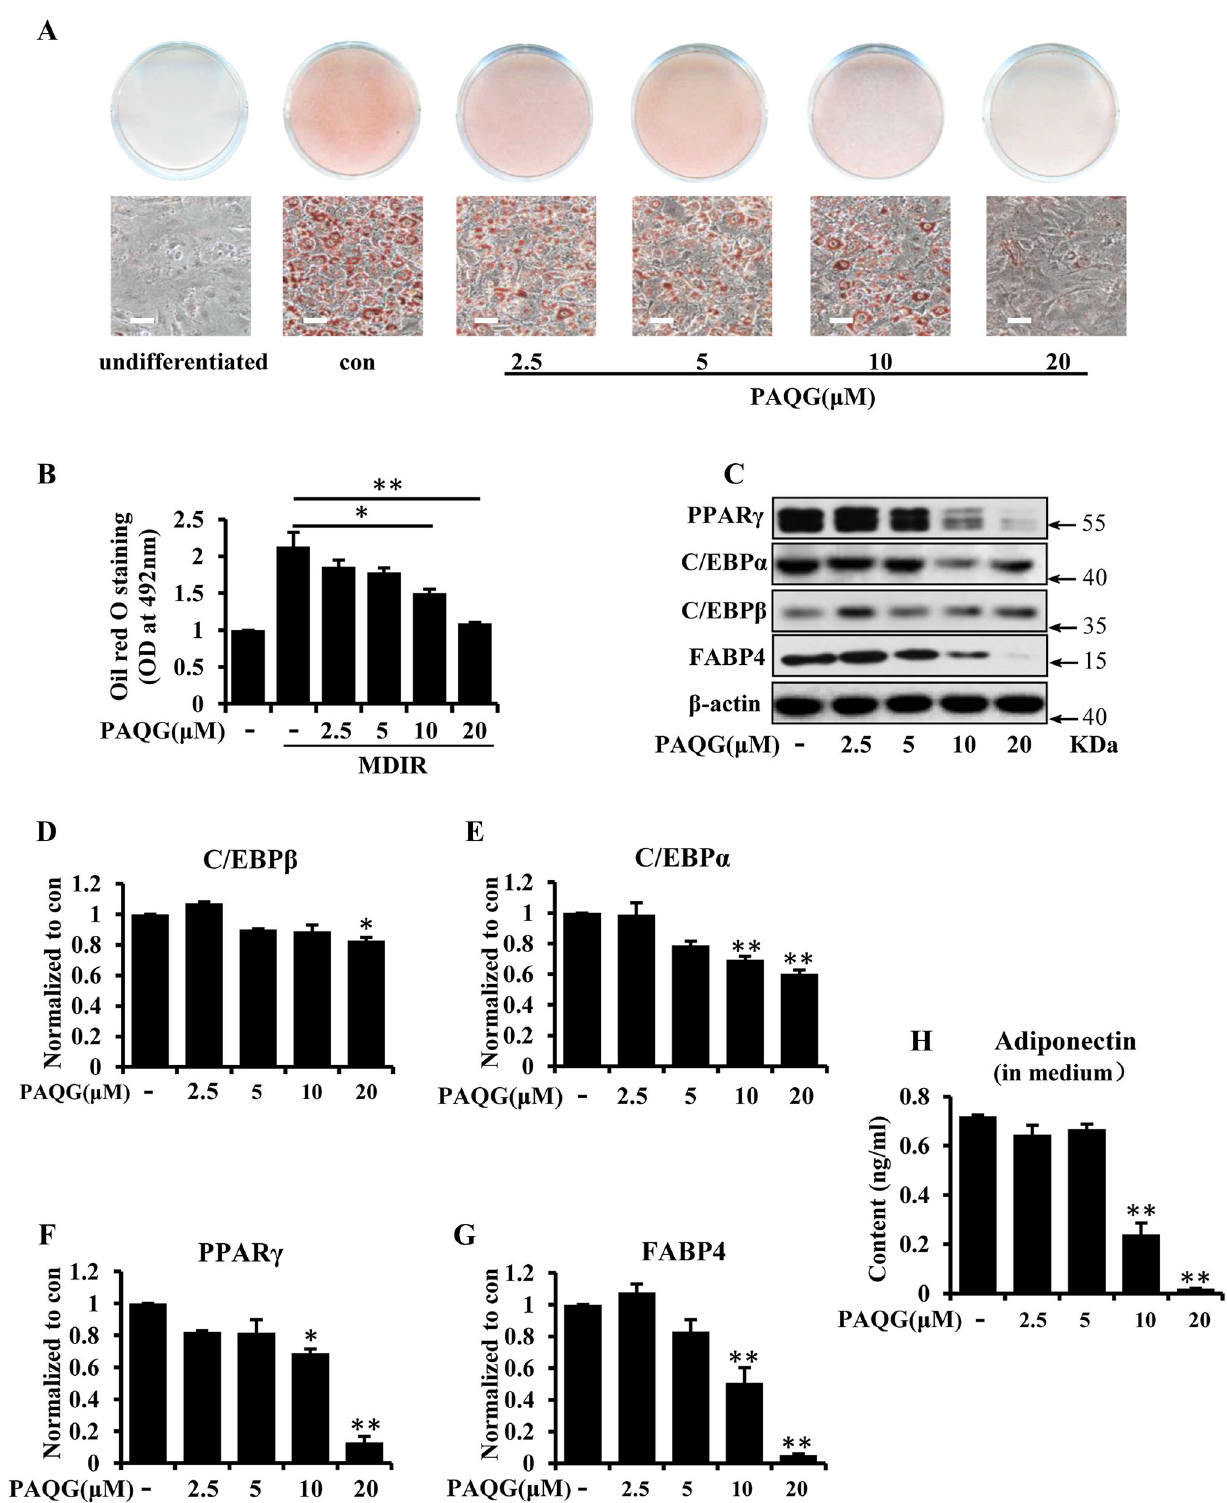
Fig. 1 PAQG inhibites adipogenesis in 3T3-L1 cells. 3T3-L1 pre- adipocytes were incubated with indicated concentrations of PAQG or vehicle for 6 days. a The cells were stained with oil red O and imaged. b Oil Red O staining was quantitatively analyzed. c The expressions of PPAR c , C/EBP a , C/EBP b and FABP4 were assessed